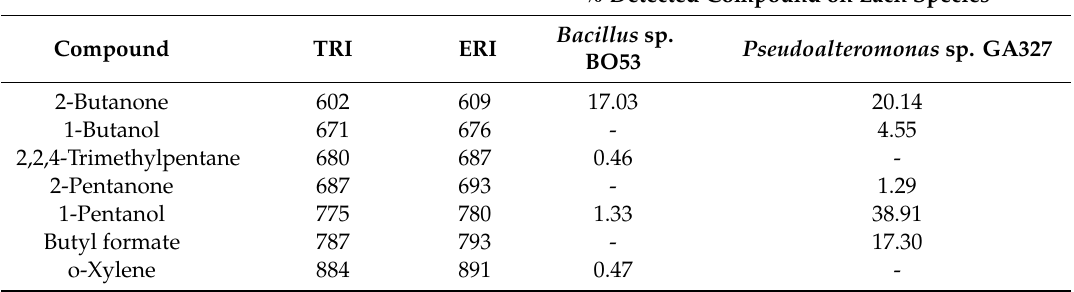
Table 2. Identified mVOCs produced by the marine bacteria Bacillus sp. BO53 and Pseudoalteromonas sp.